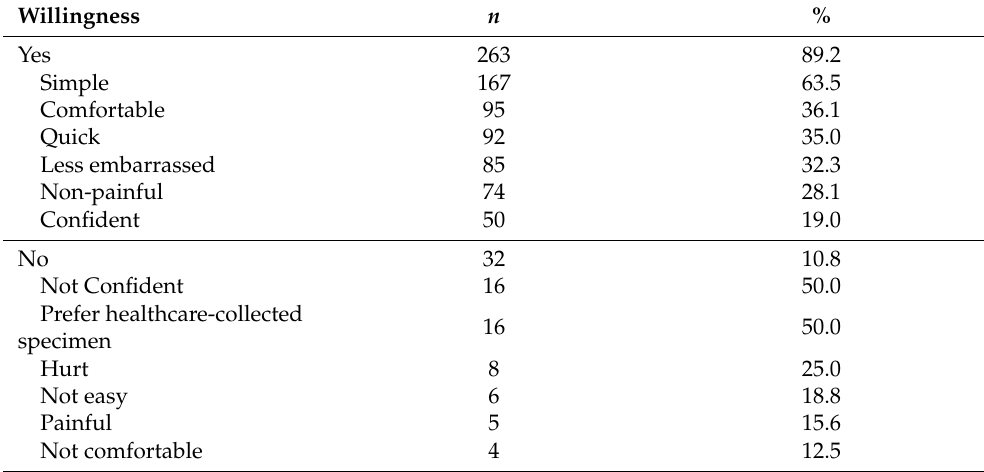
Table 5. Women’s willingness to perform self-sampling again and